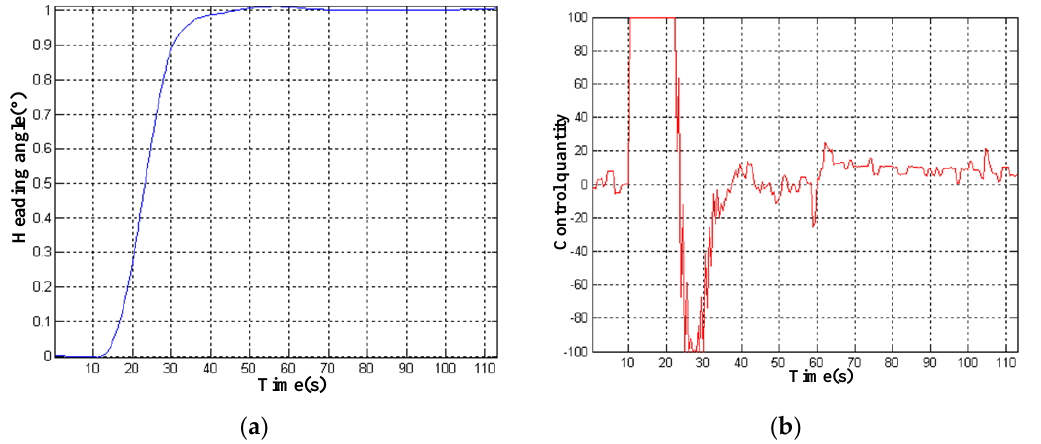
Figure 20. Step response of adaptive predictive PID Controller . ( a ) heading; ( b ) controlled quantity.